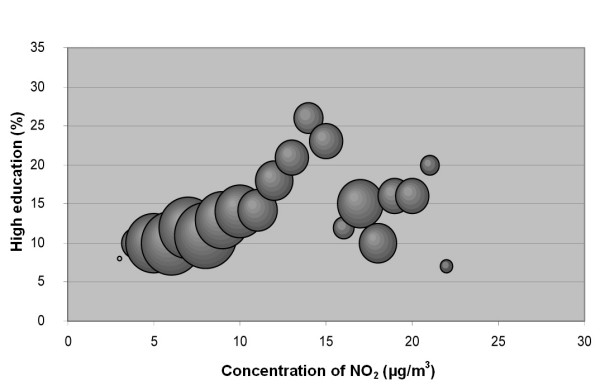
Bubble diagram for Scania; Percentage of population in Scania with high education versus annual mean concentration of NO2 at their real estate. The bubbles are sized according to the weight of the estimate, which depends on the size of the population that the estimate is based on. The weight is thus a measure of the uncertainty in the estimate, and large bubbles represent more certain and influential estimates than small bubbles.